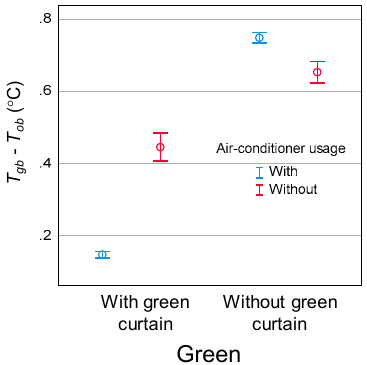
Figure 17. Di ff erence between the balcony globe temperature and balcony air Figure 17. Difference between the balcony globe temperature and balcony air temperature. Figure 17. Difference between the balcony globe temperature and balcony air temperature. Figure 17. Difference between the balcony globe temperature and balcony air temperature.